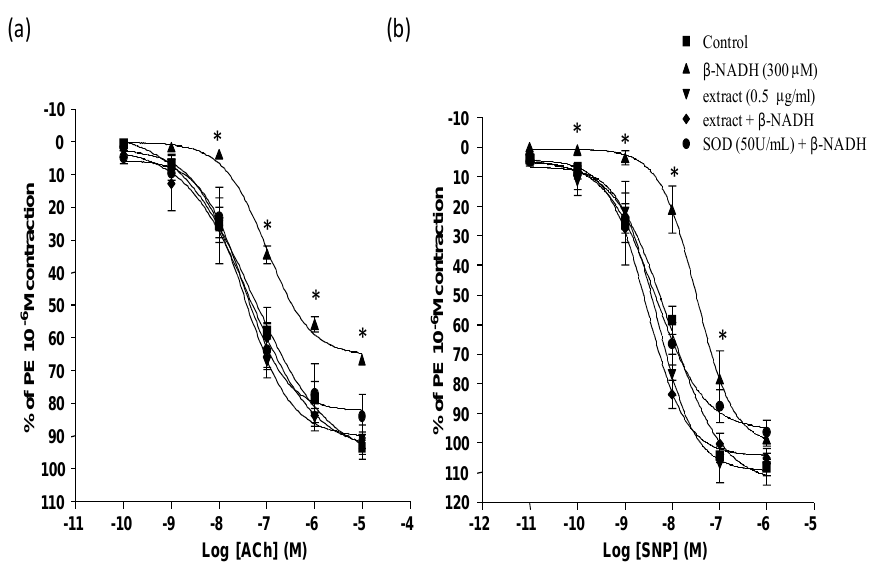
Figure 3. Effect of SOD, a superoxide scavenger and 0.5 μ g/mL P.grandis (stem bark) methanolic extract in the presence of β -NADH on (a) ACh and(b) SNP- induced relaxation in rat aortic rings. Results are mean ± S.E.M (n = 5–6). Significant difference from control is indicated by * (p < 0.05).